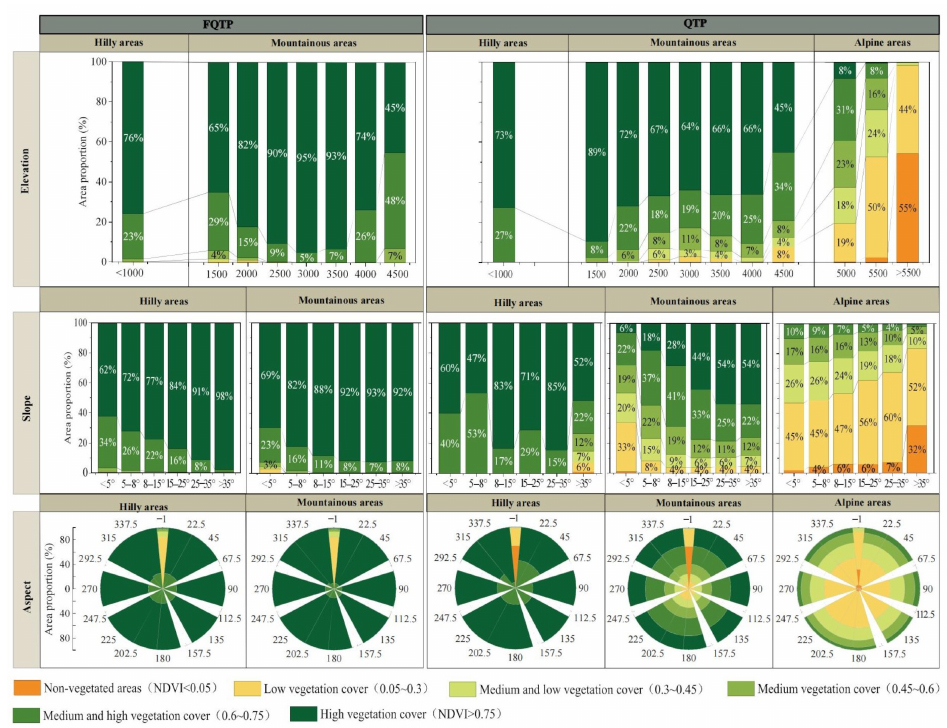
Figure 5. Area statistics of multi-year mean NDVI for topography factors during